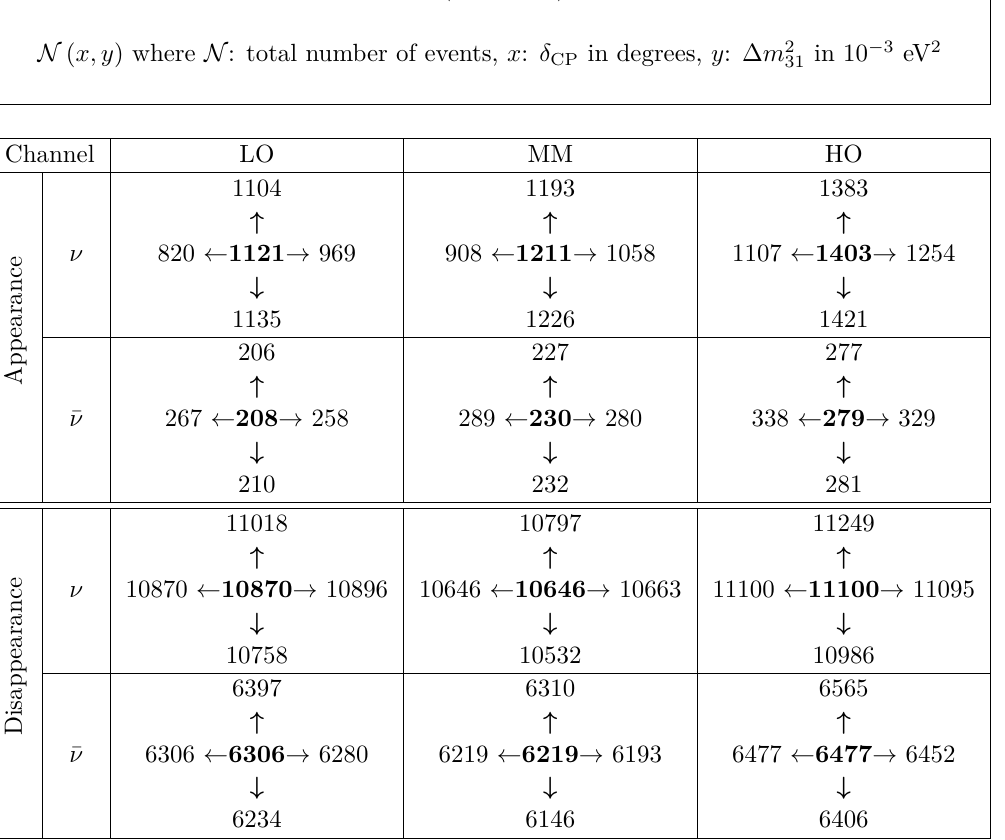
Table 2 . Total appearance and diappearance event rates in ν and ¯ ν mode. We assume 3.5 years of ν run and 3.5 years of ¯ ν run and estimate the event rates for three different choices of sin 2 θ 23 : 0.455 (LO), 0.5 (MM), and 0.599 (HO). The central number in each cell corresponds to the current best-fit values of δ CP = 223 ◦ and ∆ m 2 = 2.522 × 10 − 3 eV 2 assuming NMO. The other four numbers in each cell show the number 31 of events corresponding to the present 3 σ lower and upper bounds in ∆ m 2 (up and down arrows) and δ CP 31 (left and right arrows). For clarity, see the schematic diagram given above this